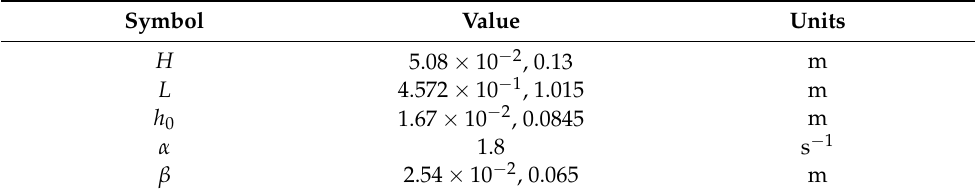
Table 2. Geometrical and process constants for benchmarking the introduced model with data from [9,35].